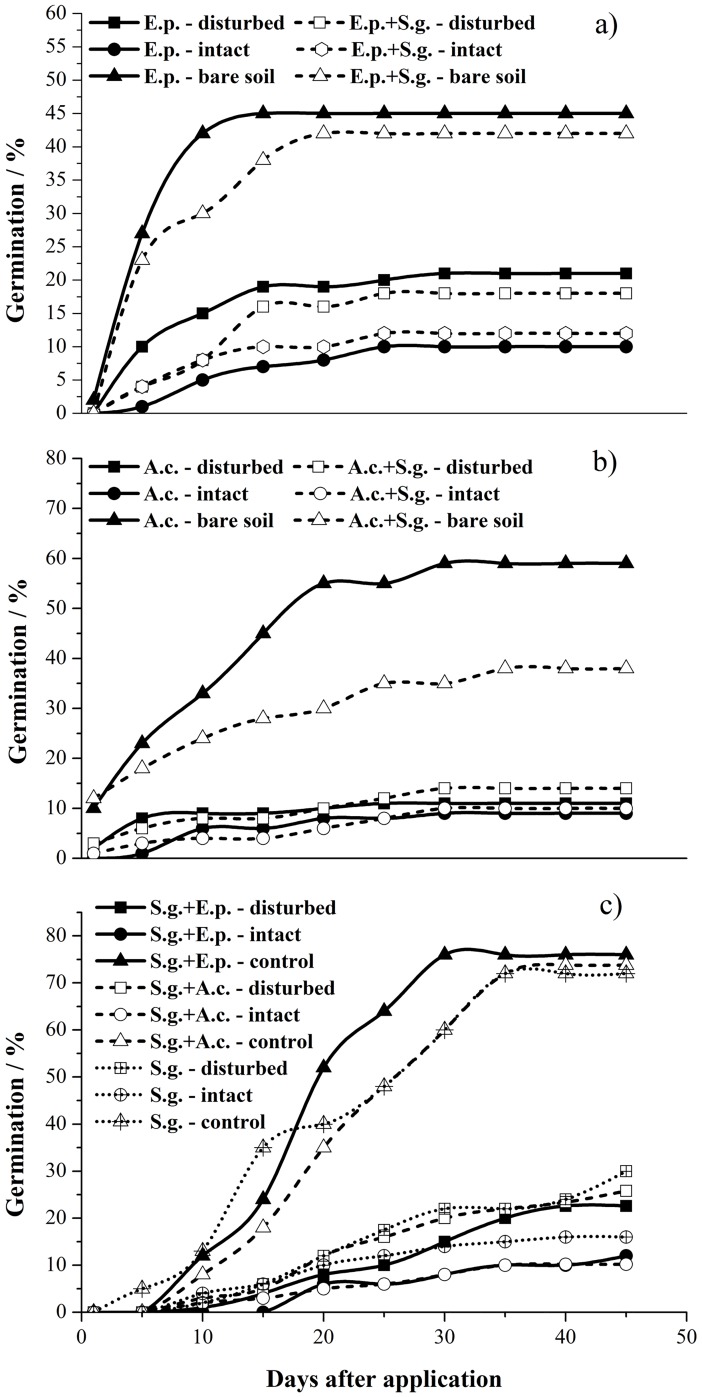
Seeds germination time courses of E. poaeoides (a), A. capillaris (b) and S. glareosa (c) in different cyanobacterial crust treatments.E.p. indicate E. poaeoides monoculture, E.P. + S.g. indicate E. poaeoides mixed cultivation with S. glareosa; A.c. indicate A. capillaris monoculture, A.c. + S.g.—indicate A. capillaris mixed cultivation with S. glareosa; S.g. + E.P. indicate S. glareosa mixed cultivation with E. poaeoides, S.g. + A.c. indicate S. glareosa mixed cultivation with capillaries and S.g. indicate S. glareosa monoculture.